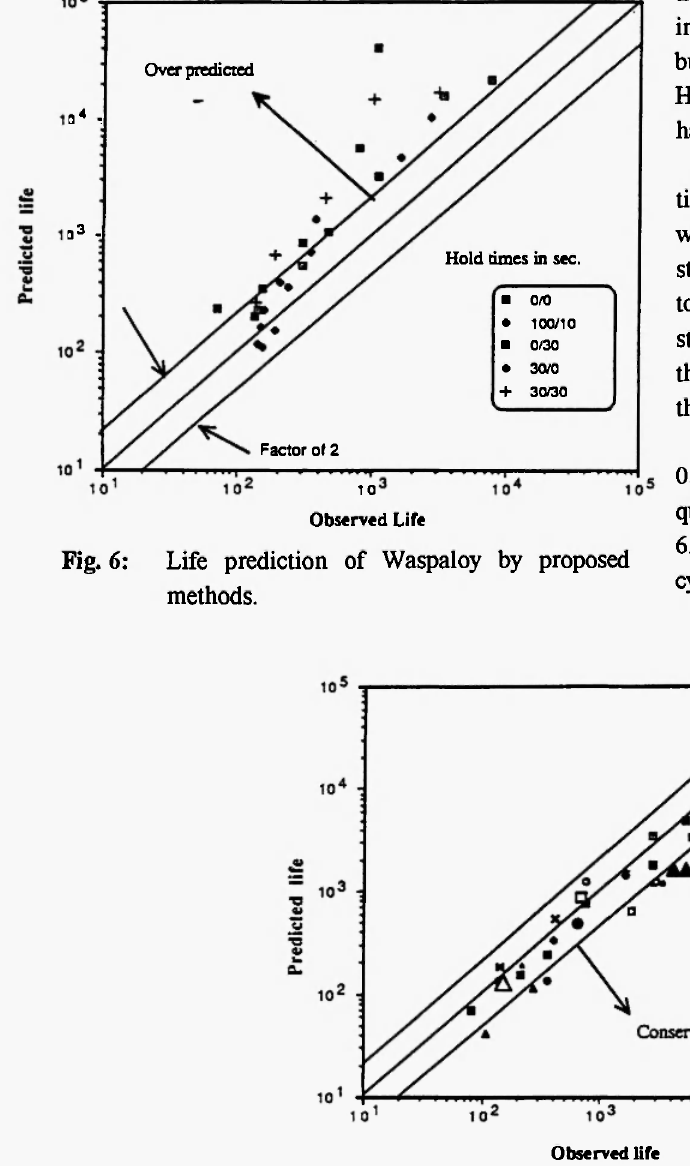
Fig. 7: Life prediction of Ti-6A1-4V by proposed